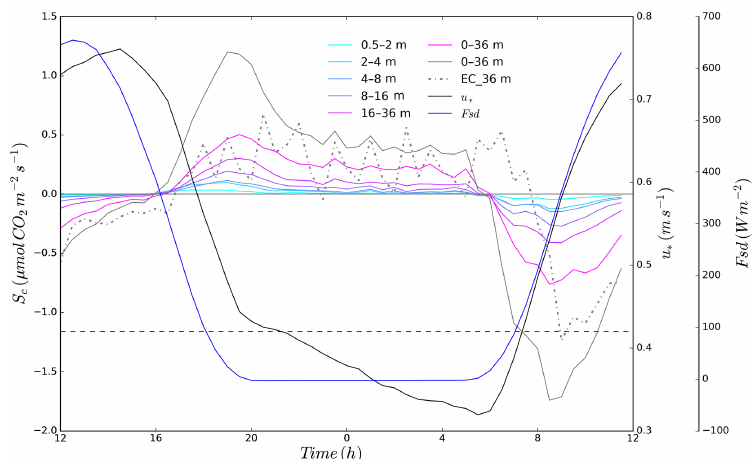
Figure 12. Mean diurnal cycle of aggregate and component S c (LH axis, solid horizontal line represents mean S c ) and u ∗ (RH axis, dashed horizontal line represents change-point-derived nocturnal u ∗ threshold for F c ) ; note that day length as indicated by insolation is > 12h due to missing data for several months during winter–spring 2013, slightly biasing the data towards a longer